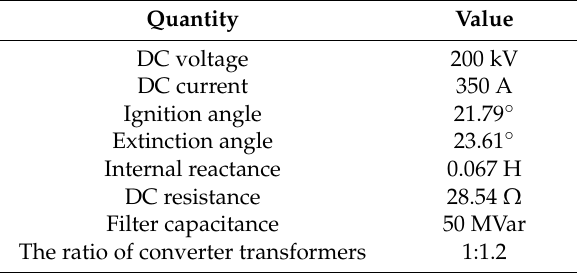
Figure 2. IEEE14-bus AC/DC hybrid system after transforming. Table 1. Basic operating parameters of the LCC-HVDC (Line Commutated Converter-High Voltage Direct Current) system.